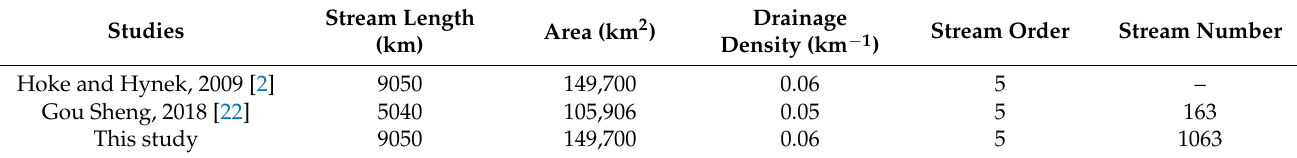
Table 4. Comparison of extracted results of Evros